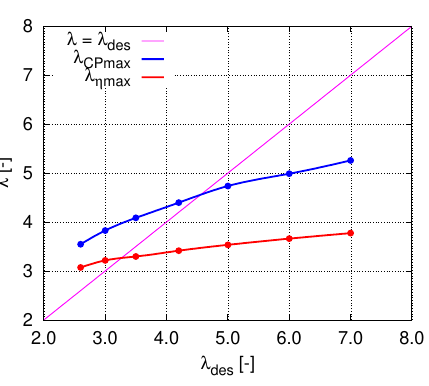
condition is met for λ des = 4 . 6 , while the condition λ ηmax = λ des occurs at λ des = 3 . 3 .